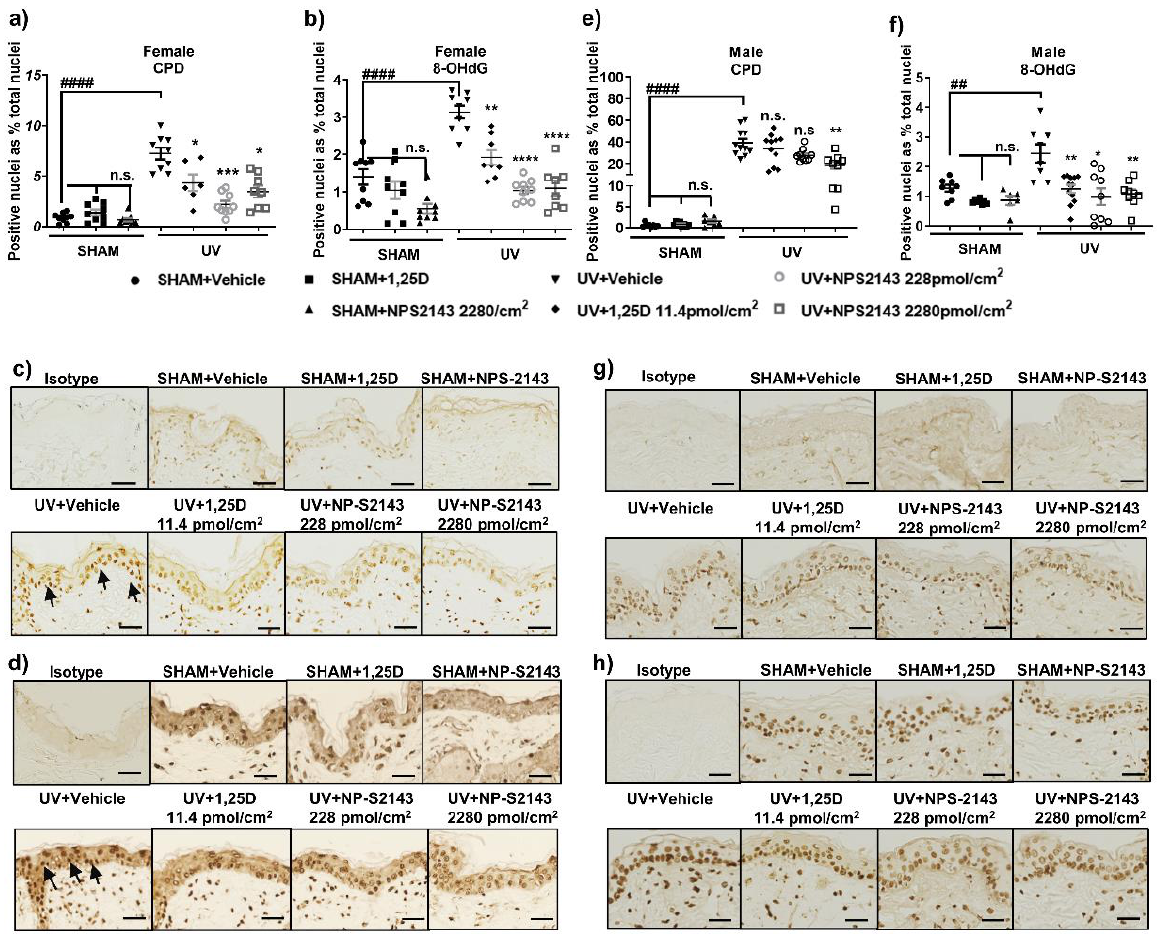
Figure 1. NPS-2143 inhibits DNA damage in female and male mouse skin following acute UV irradiation. Immediately after exposure to ssUV, female and male Skh:hr1 mice were treated with ve- hicle 1,25D (11.4 pmol/cm 2 ) or NPS-2143 (228 or 2280 pmol/cm 2 ) topically and the skin was harvested after 3 h. DNA damage is shown in graphs for CPD in female ( a ) or male ( e ) mice and 8-OHdG in female ( b ) or male ( f ) mice with graphs displaying data as dot plots. These graphs show representa- tive data from a minimum of two individual experiments with similar results on each occasion. **** p < 0.0001, *** p < 0.001, ** p < 0.01, * p < 0.05, and n.s. not significant, when compared with UV- vehicle treated group by linear mixed model analysis; ## p < 0.01, #### p < 0.0001 significantly different from sham vehicle by t -test ( a ): t = 6.088, df = 10 ( b ): t = 5.385, df = 10 ( c ): t = 6.084,df = 13,( d ): t = 2.728, df = 10. n = 9 (triplicate biopsies per mice, 3 mice per group). Photomicrographs show UV-induced CPD in female ( c ) or male ( g ) mice and 8-OHdG in female ( d ) or male ( h ) mice. Black arrows point to the dark brown staining in nuclei indicating the presence of DNA damage. Scale bar = 100 μm.